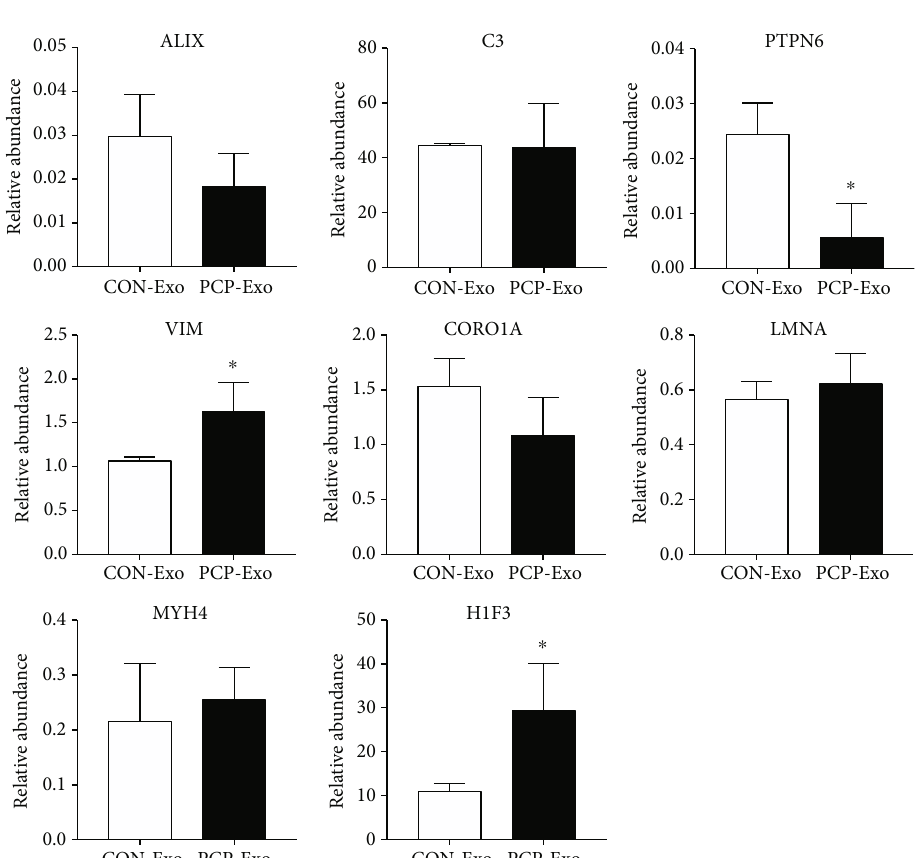
Figure 5: Validation of the selected proteins using PRM. Exosomes of CON and PCP B cells were isolated and subjected to LC-PRM/MS analysis. Relative protein abundance of eight proteins (ALIX, C3, PTPN6, VIM, CORO1A, LMNA, MYH4, and H1F3) was calculated based on the normalized peak area of peptide fragments. A two-tailed Student ’ s t test was used to detect the di ff erence between two groups ( n = 3 ). ∗ indicates p < 0 : 05